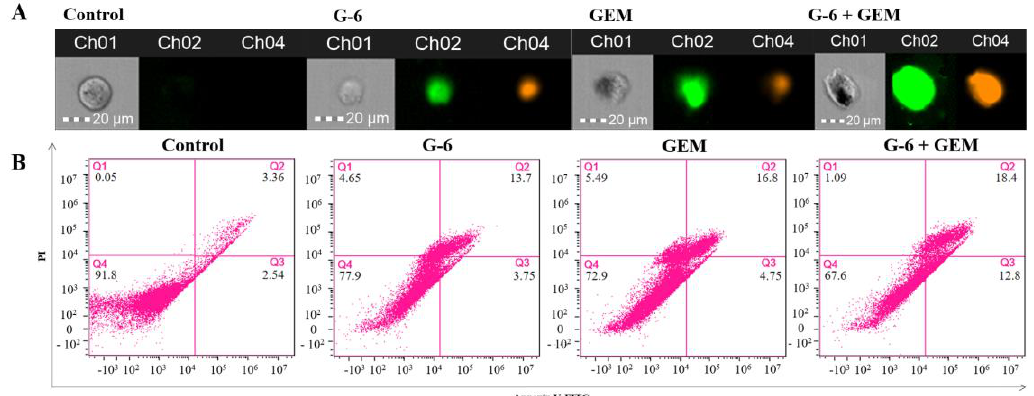
Figure 6. G-6 combined with GEM induced apoptosis in SW1990 cells. ( A ) Representative fluores- cent images of Annexin Ⅴ /PI co-staining in SW1990 cells. ( B ) Annexin Ⅴ /PI co-staining was used to images of Annexin V/PI co-staining in SW1990 cells. ( B ) Annexin V/PI co-staining was used to detect apoptosis rate. Scale bar = 20 µm. detect apoptosis rate. Scale bar = 20 µ